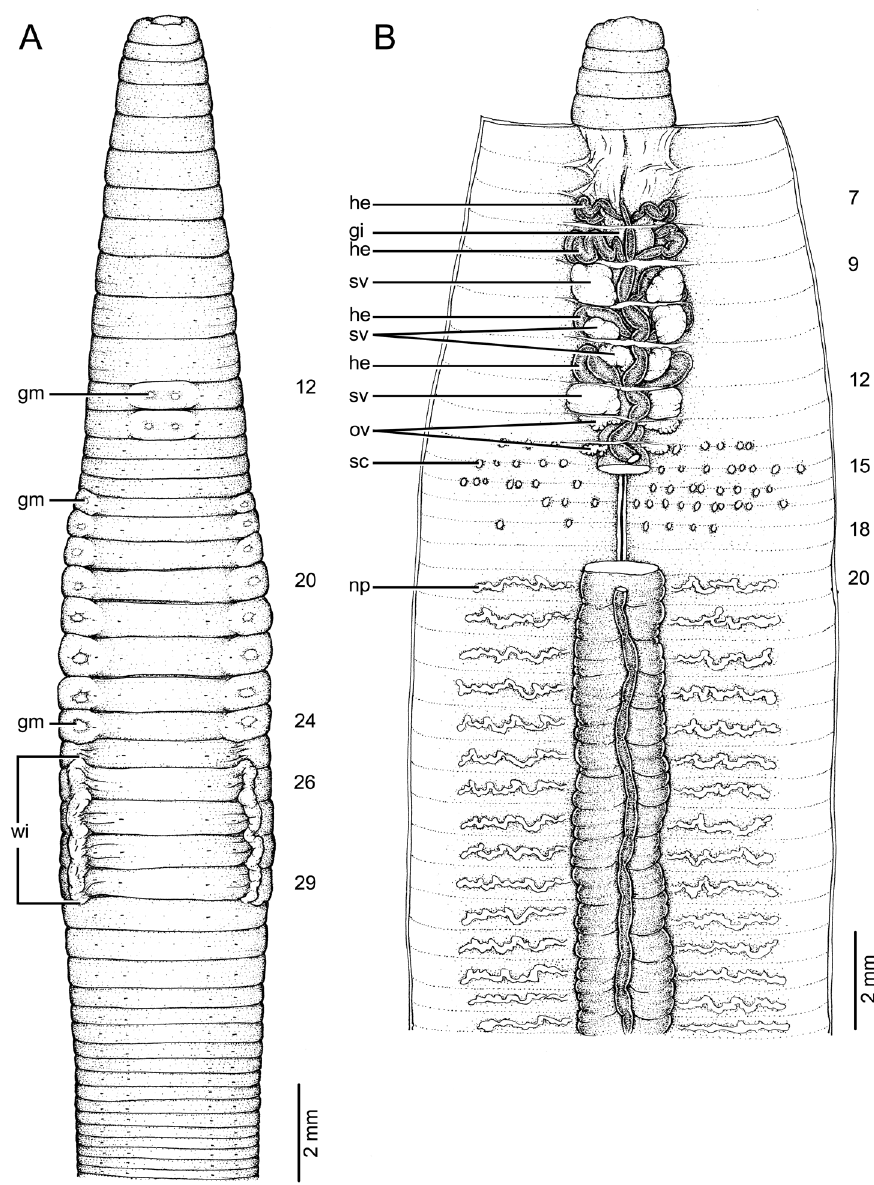
Figure 4. Morphology of holotype (CUMZ 3403) of Glyphidrilus nanensis sp. n. A external ventral view, annular clitellum in XVII–XXXIII B internal dorsal